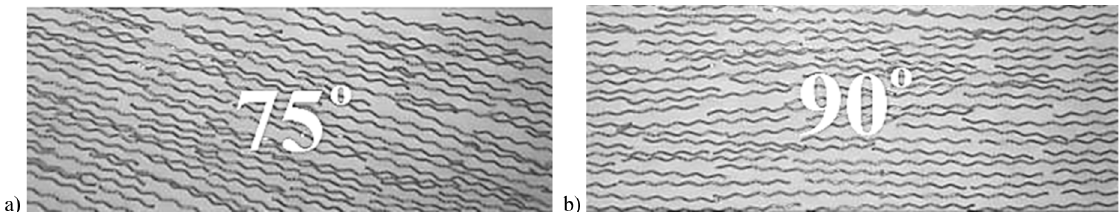
Fig. 1. Warps with attached sets of fibers oriented under the angle 75° (a) and (b) 90° to the prism longitudinal axis